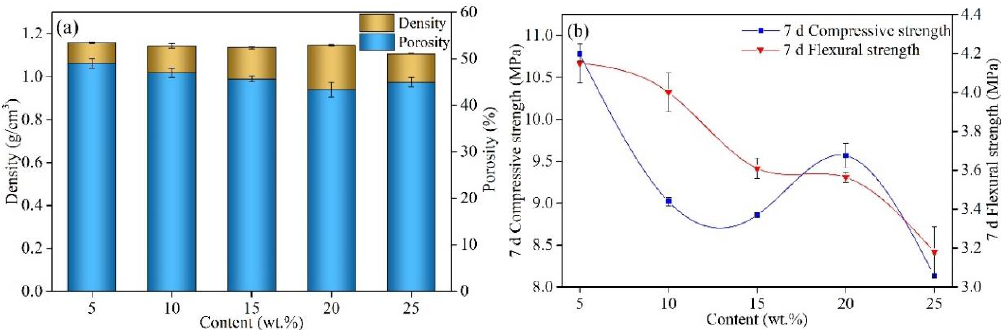
Figure 1. ( a ) Densities, porosities, ( b ) 7 d compressive strengths, and 7 d flexural strengths of the PA/gypsum